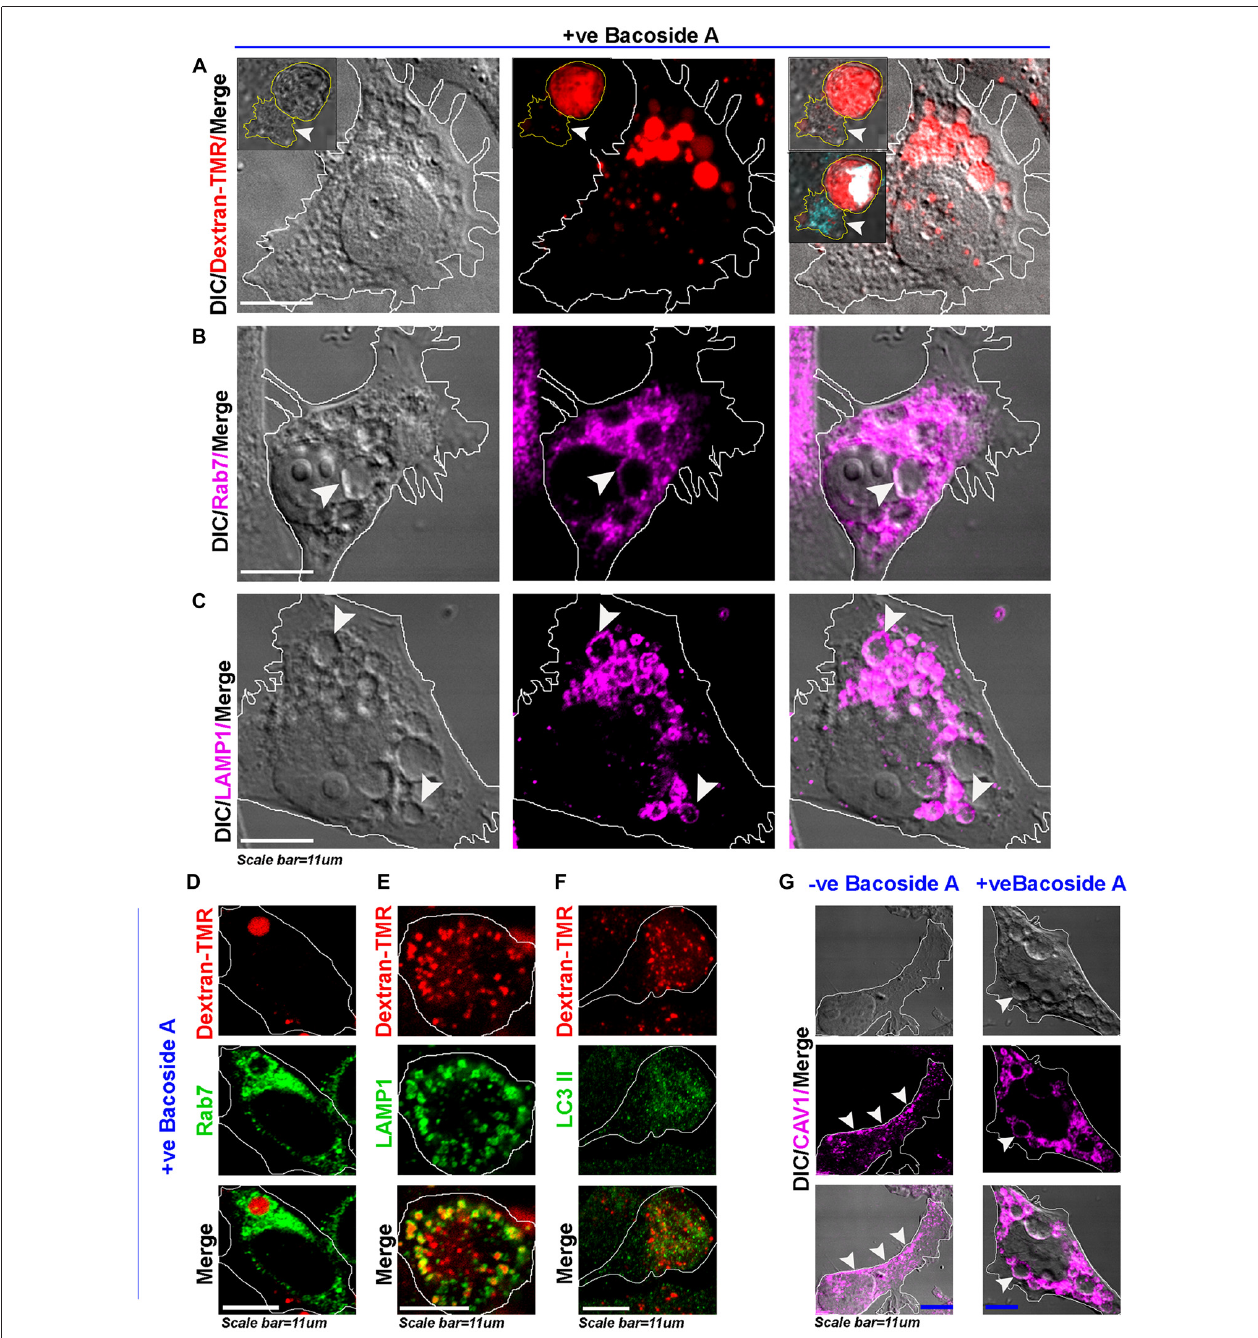
FIGURE 8 | Bacoside A induced enlarged vacuoles are macropinosomes that undergo time dependent pre-lysosomal fusion. (A) Confocal images of Bacoside A (12 h) treated LN229 glioblastoma cells showed large vacuoles positive for dextran-TMR (red), a marker of macropinosomes. Insets in the panel shows that in 24 h Bacoside A treated LN229, cells had rounded off and were filled with dextran-TMR, delivered by macropinosomes to the cytoplasm. Hence, cell swelling was a net consequence of excess fluid uptake by the tumor cells. The white arrowhead points to a necrotic cell attached to swelled cell with squashed nucleus (cyan/white). The vacuoles were identified to be positive for late endosome/macropinosome markers. (B) Rab7 and (C) LAMP1. White arrows in panels (B,C) , points to the localization of Rab7 and LAMP1 surface proteins to the membranes of vacuoles. (D) shows Dextran-TMR positive macropinosome surface positivity for Rab7 (green). Similarly, (E) shows Dextran-TMR positive macropinosome surface positivity for LAMP1 (green) but (F) not for LC3II, an autophagosome marker (also see Supplementary Figure S8). (G) The Bacoside A treated LN229 tumor cell vacuolar membranes were also positive for caveolin-1 protein and in many vesicles it was noticed in the vesicle lumen, suggestive of both caveolar/surface origin of vacuoles and non-caveolar surface origins from the caveolar flattened areas respectively. Overall, treated cells showed major loss of surface CAV1 in comparison to untreated LN229 cells. The images are representative of five independent experiments.